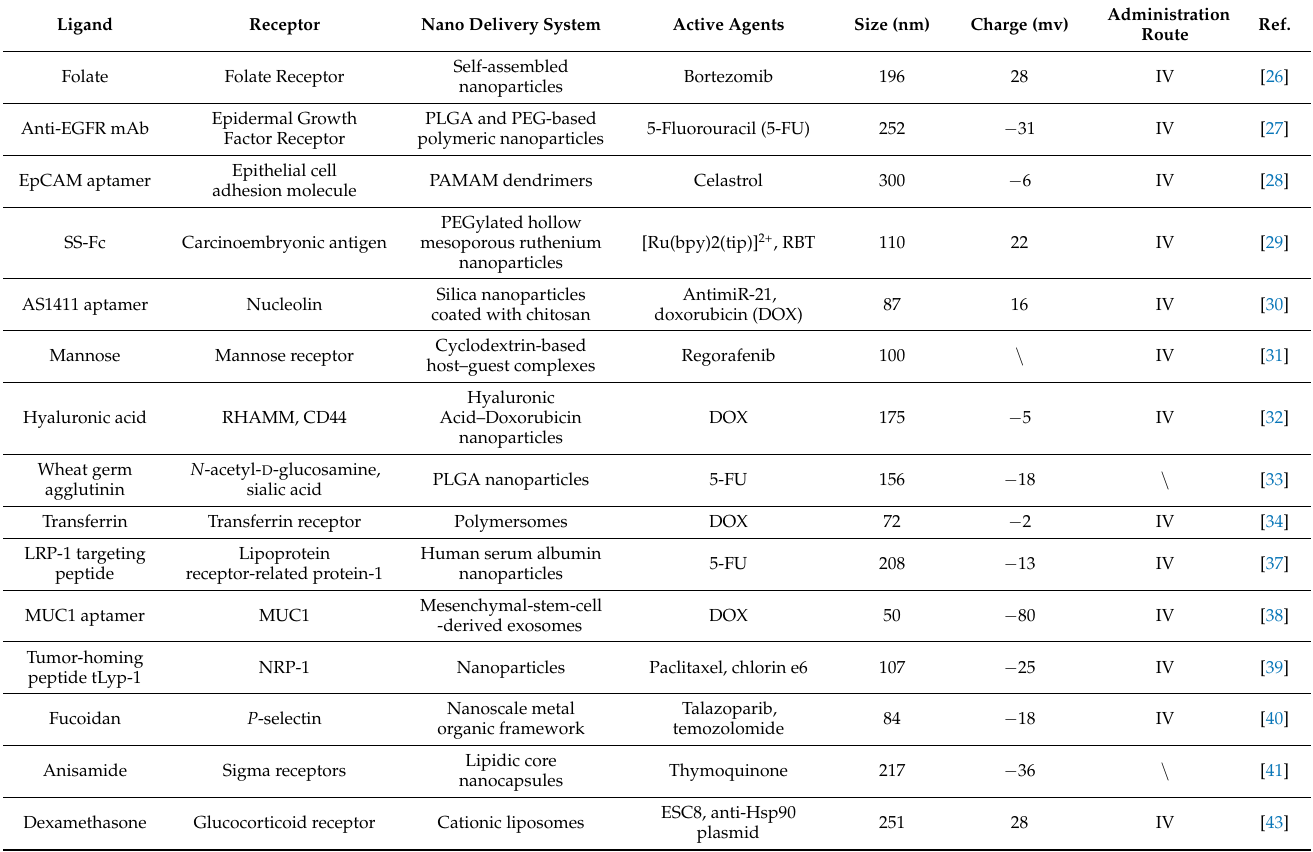
Table 1. Actively targeting nano delivery system for the treatment of colorectal